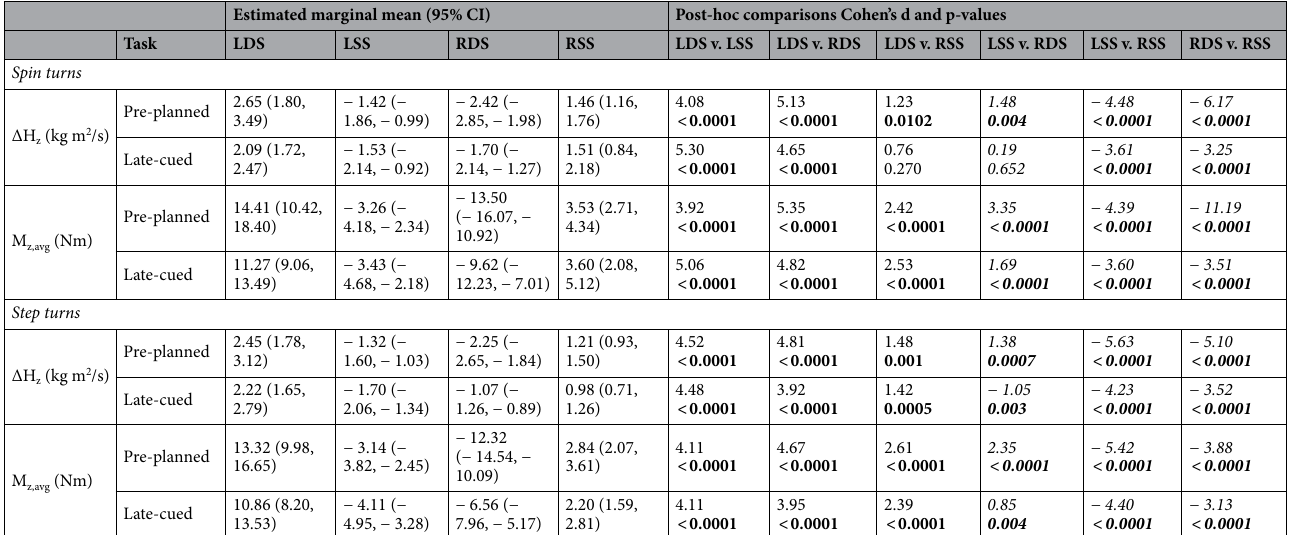
Table 5. Group-level estimated marginal means for angular study outcomes from linear mixed models by turn strategy. Acronyms: Left Double Support (LDS) Left Single Support (LSS), Right Double Support (RDS), Right Single Support (RSS), change in transverse-plane angular momentum (∆H z ) and average transverse-plane moment (M z,avg ). Positive values for H z and M z rotate the body leftwards, in the direction of the turn. Bolded p-values indicate statistically significant differences. Italic text indicates comparisons that were not related to the left double support phase that was pertinent to the